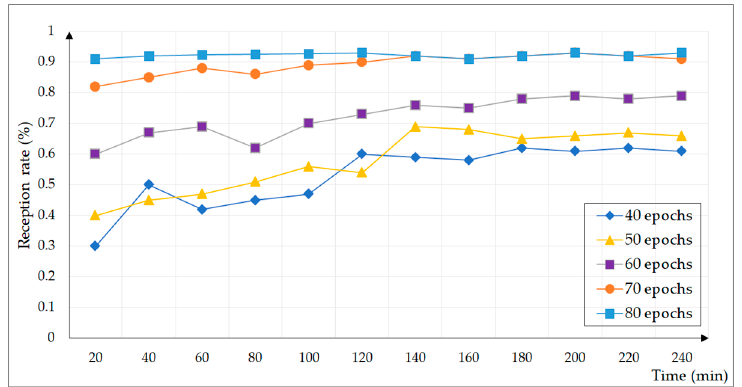
Figure 10. Reception rate over time for learning epochs.